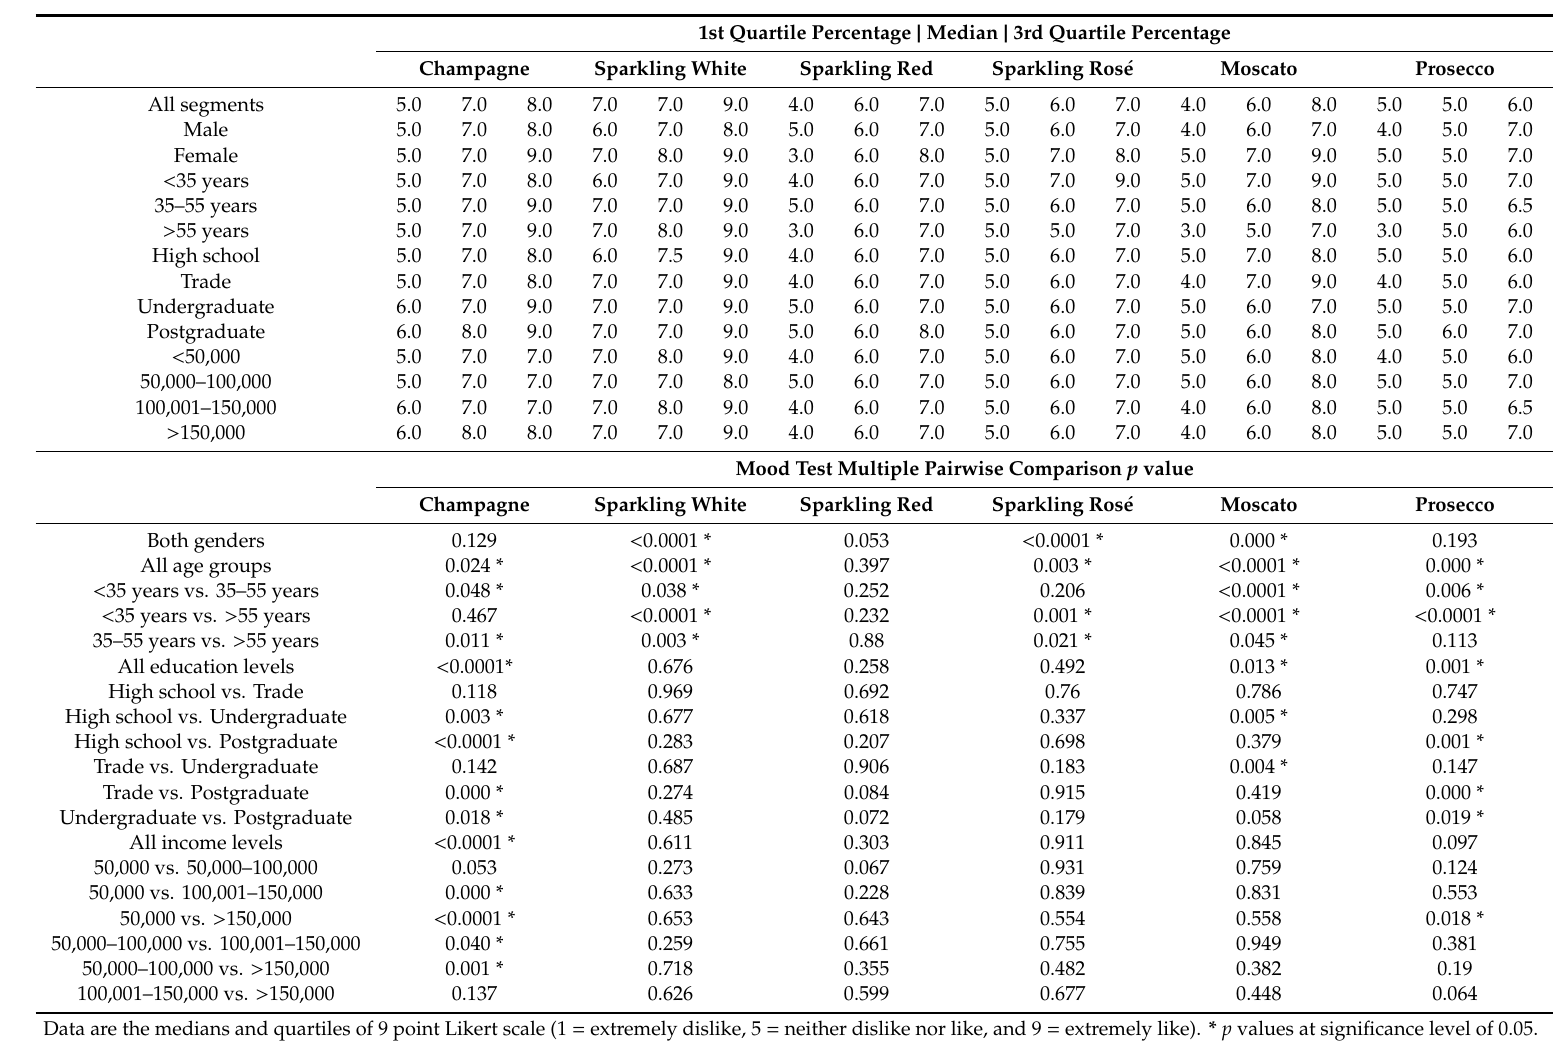
Table 6. Quartile and median liking scores and comparisons of gender, age, education and household income (AUD) segments for di ff erent sparkling wine